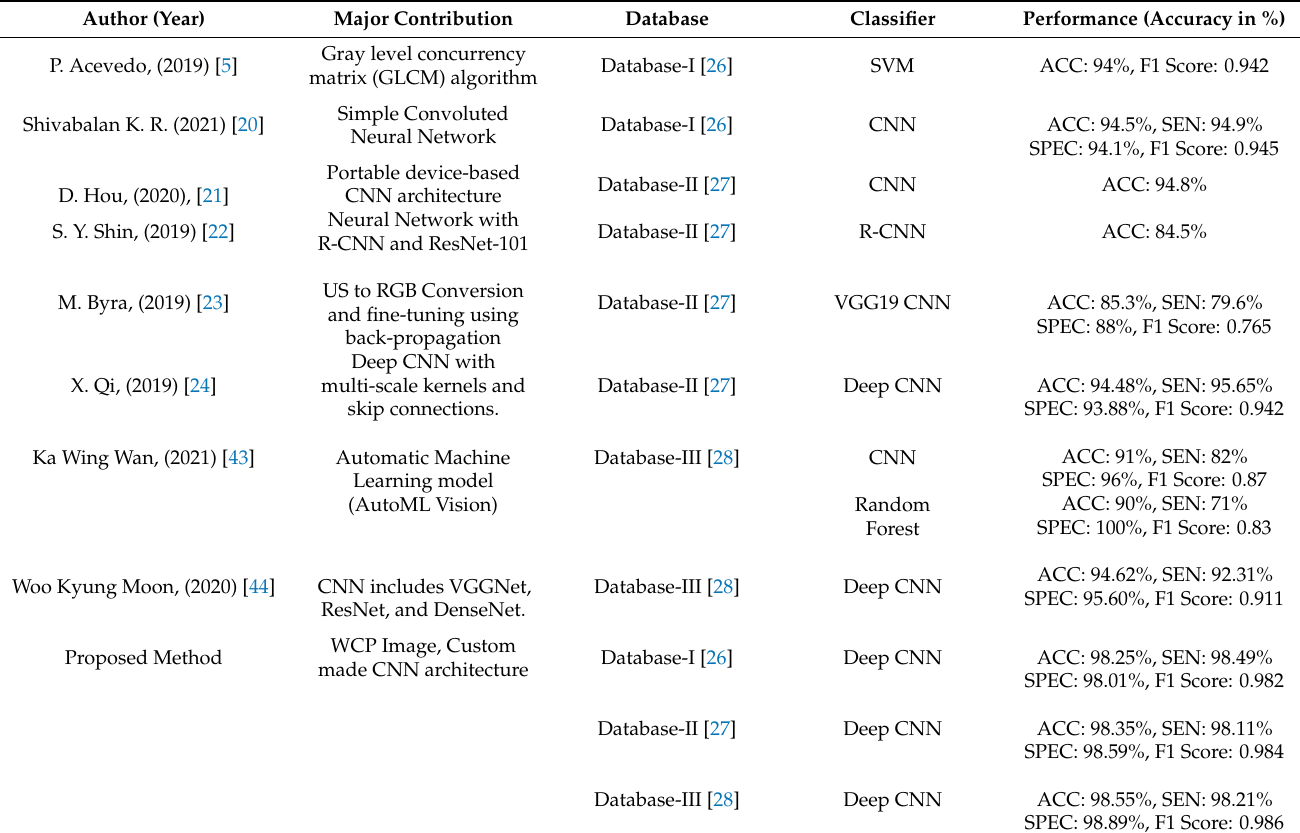
Table 8. A comparison of selected studies with the proposed classification scheme using databases I, II, and III.